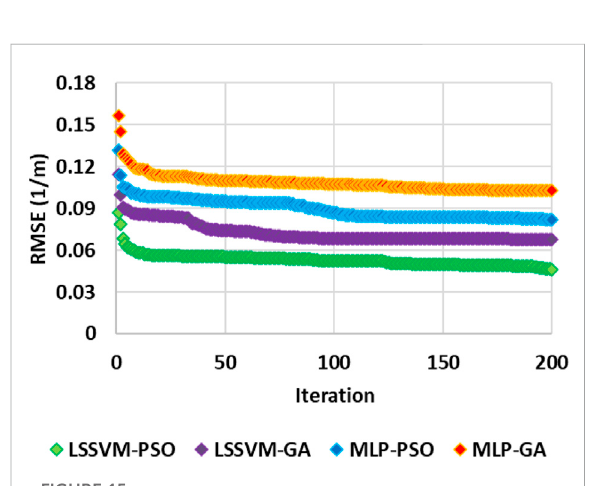
FIGURE 15 The RMSE vs. iteration for determination of the for four